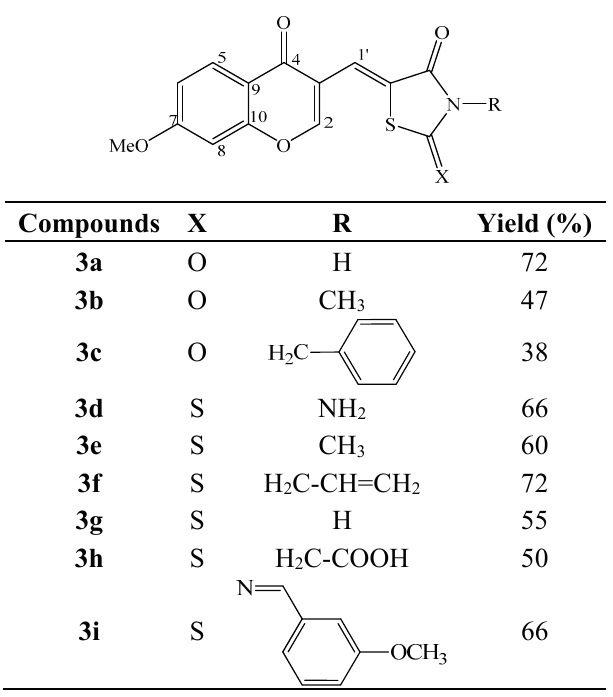
Table 1. Synthesized chromonylthiazolidines 3a – i .